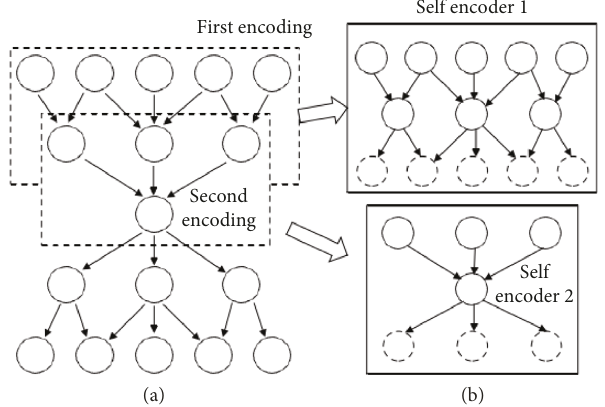
Figure 4: Schematic diagram of the stacked autoencoding layer-by- layer training